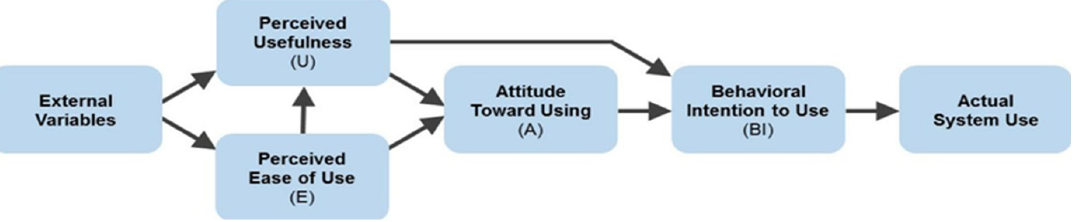
Fig. 1 Technology Acceptance Model